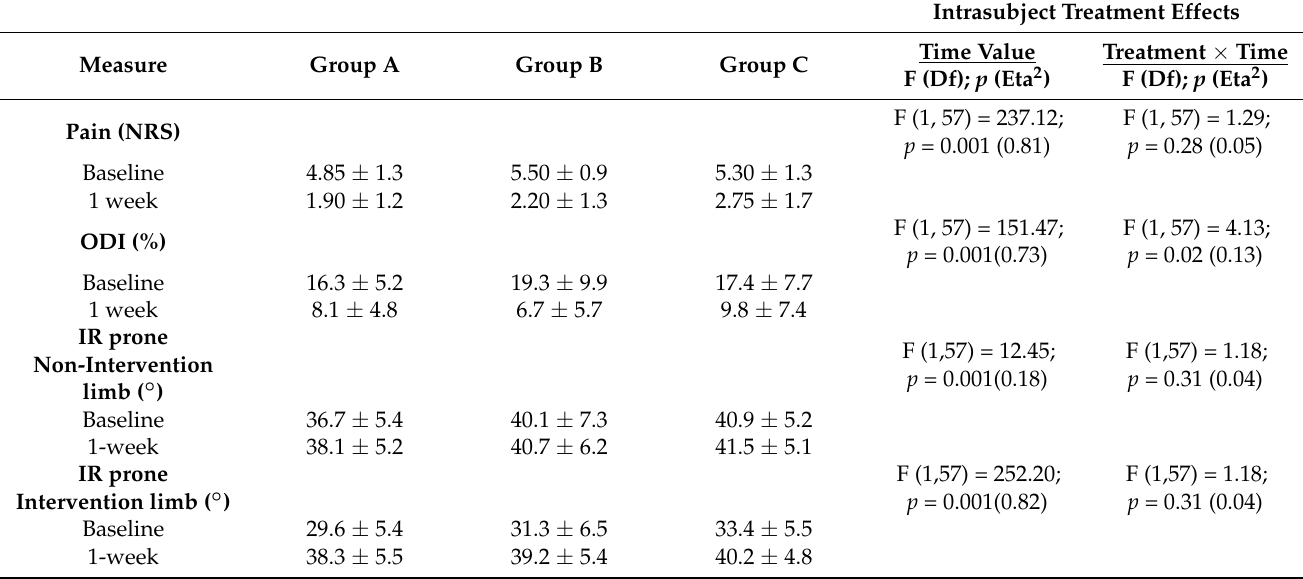
Table 2. Pain level, Oswestry Disability Index (ODI) and internal rotation range of motion for both limbs (IR-ROM) intrasubject treatment